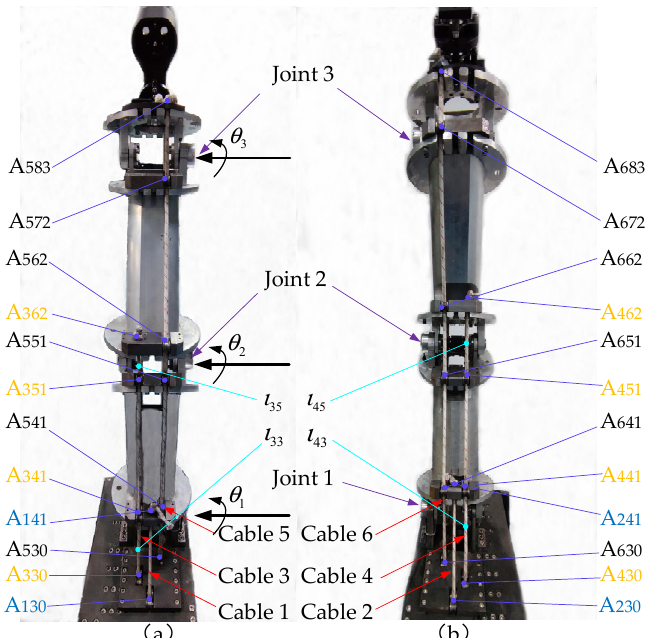
Figure 4. Protype of a plane three-DOF six-cable CDM. ( a ) Front side; ( b ) Back side; The first two attachments A i 10 , A i 20 of cable i ( i = 1, · · · ,6) are located at two fixed reversing pulleys, which is